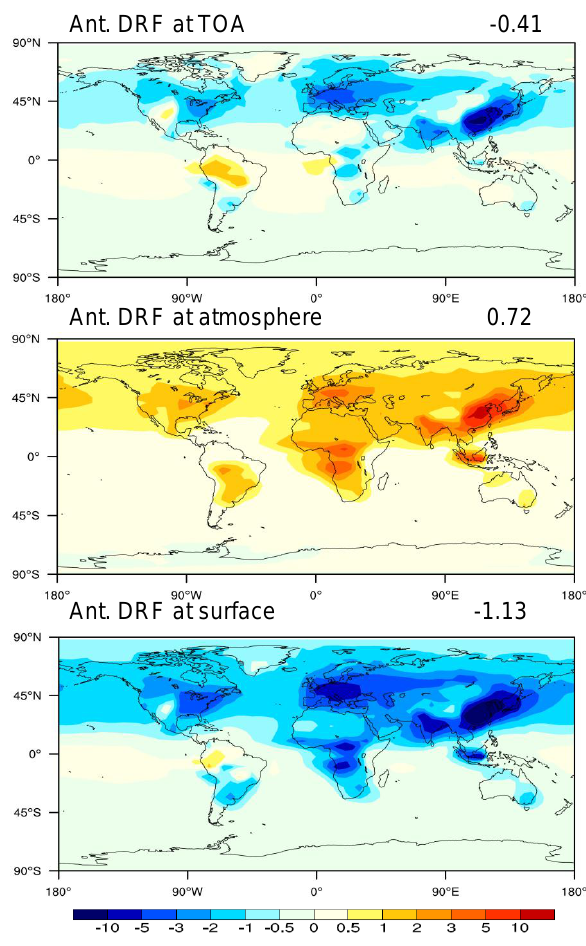
Fig. 7. Annual mean anthropogenic aerosol DRF at TOA, atmo- sphere and surface for all sky. The global mean values are shown on the right top of each plot. Unit: Wm − 2